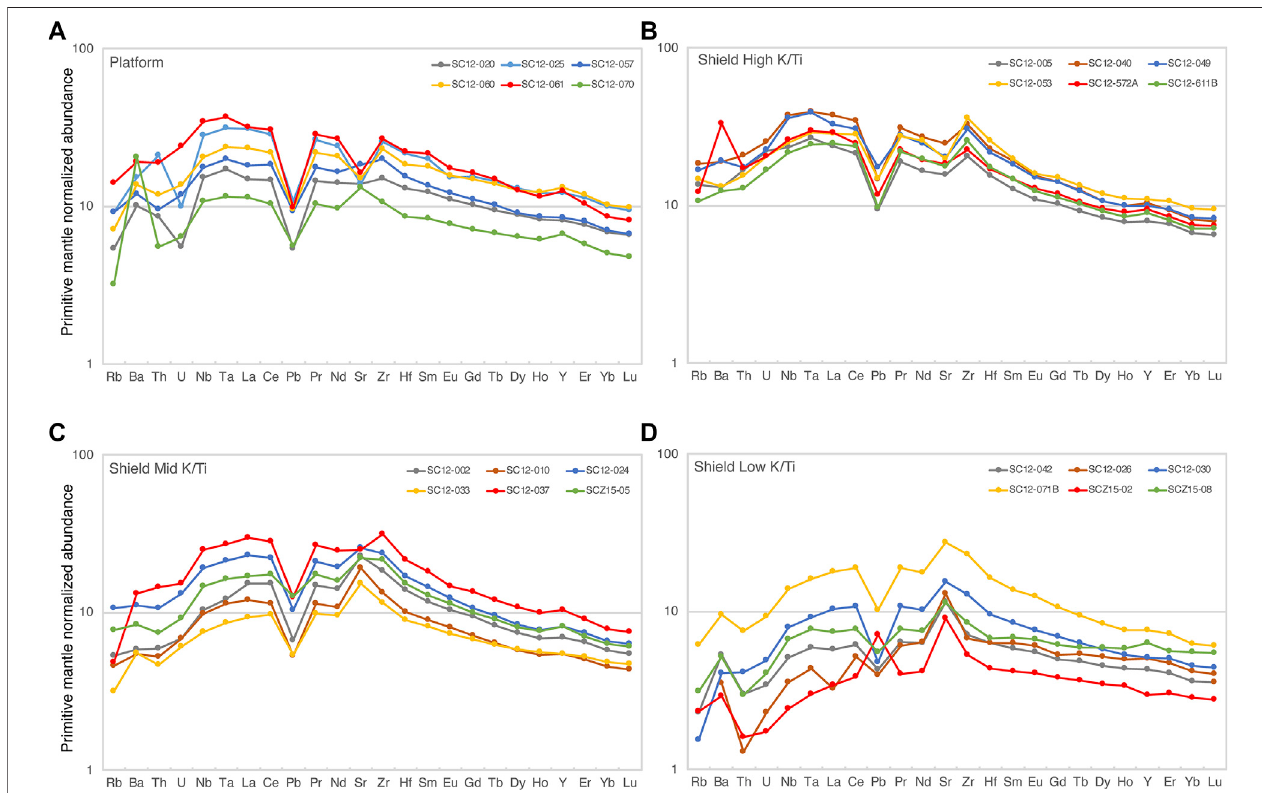
FIGURE 6| Representative trace element contents of Santa Cruz lavas normalized toprimitive mantle (McDonough and Sun, 1995). All symbolsare larger than 1 σ analytical error. (A) Platform Series. (B) High K 2 O/TiO 2 Shield Series. (C) Mid K 2 O/TiO 2 Shield Series. (D) Low K 2 O/TiO 2 Shield Series.